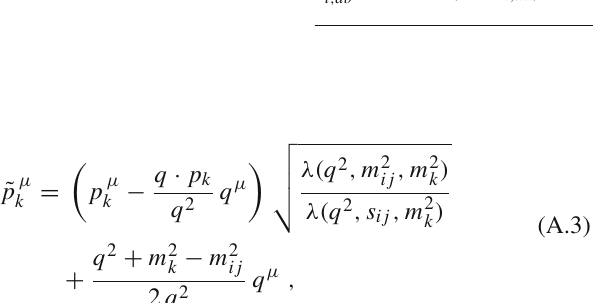
Table 3 Scaling of Catani–Seymour parameters defined in Eqs. (A.1) and (A.2) used to construct the phase-space trajectories in Sect. 3.1. The scaling parameter is denoted by λ , and the gluon is labeled as particle